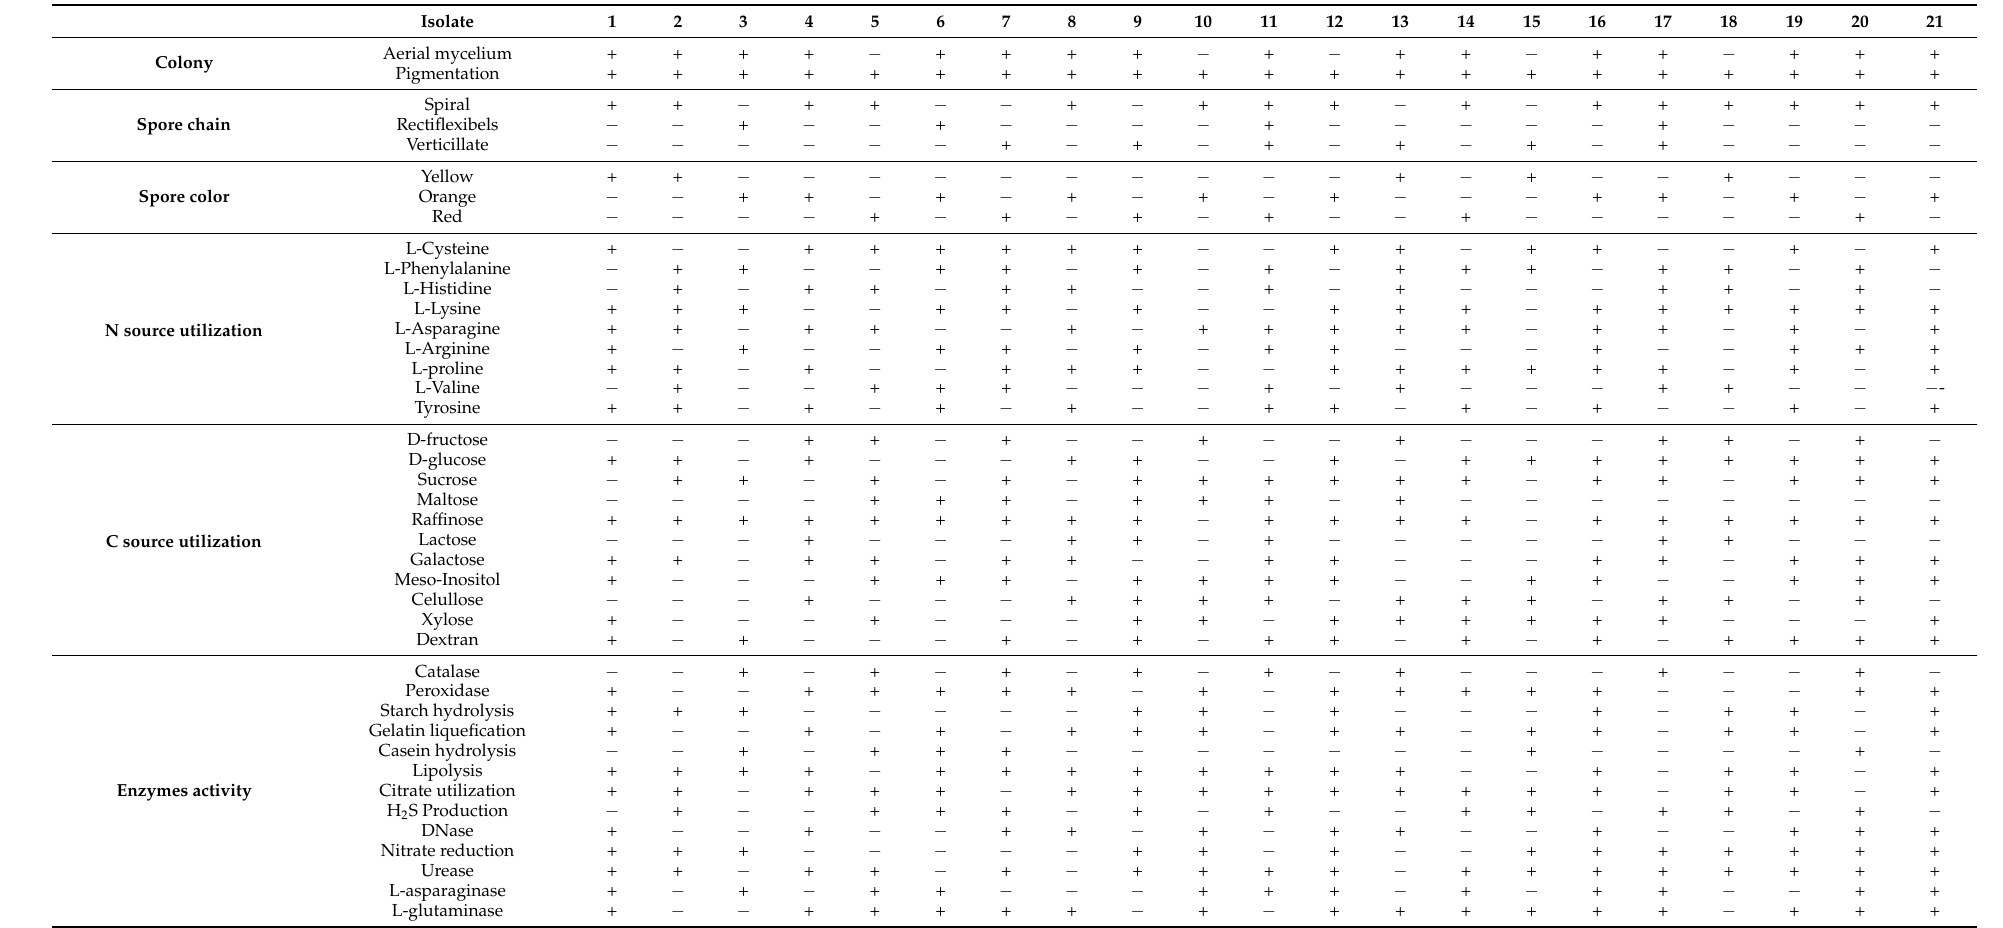
Table 1. The morphological and biochemical characterization of 21 bacterial isolates. The signs + and − indicate presence or absence, respectively. Isolate 1 2 Colony Aerial mycelium + Spiral + + − Spore chain Yellow Spore color